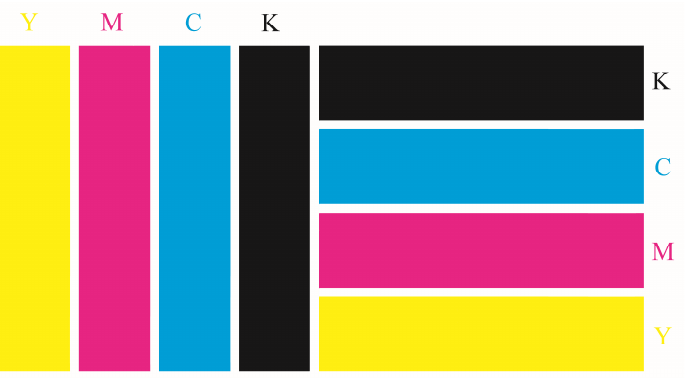
Figure 9. Design drawing of inkjet color printing sample.